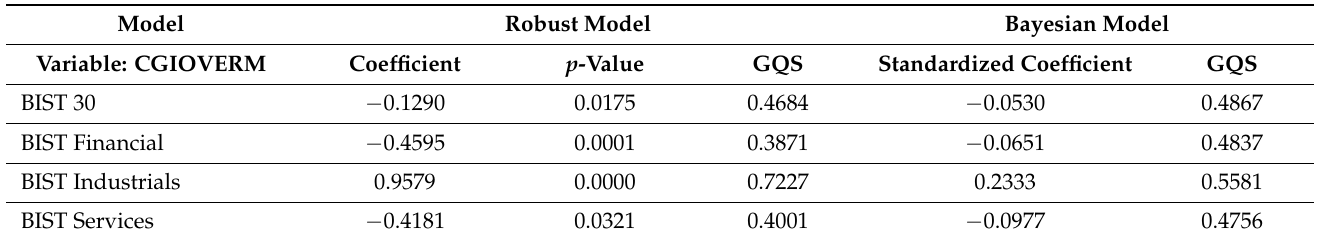
Table 11. Implied governance quality